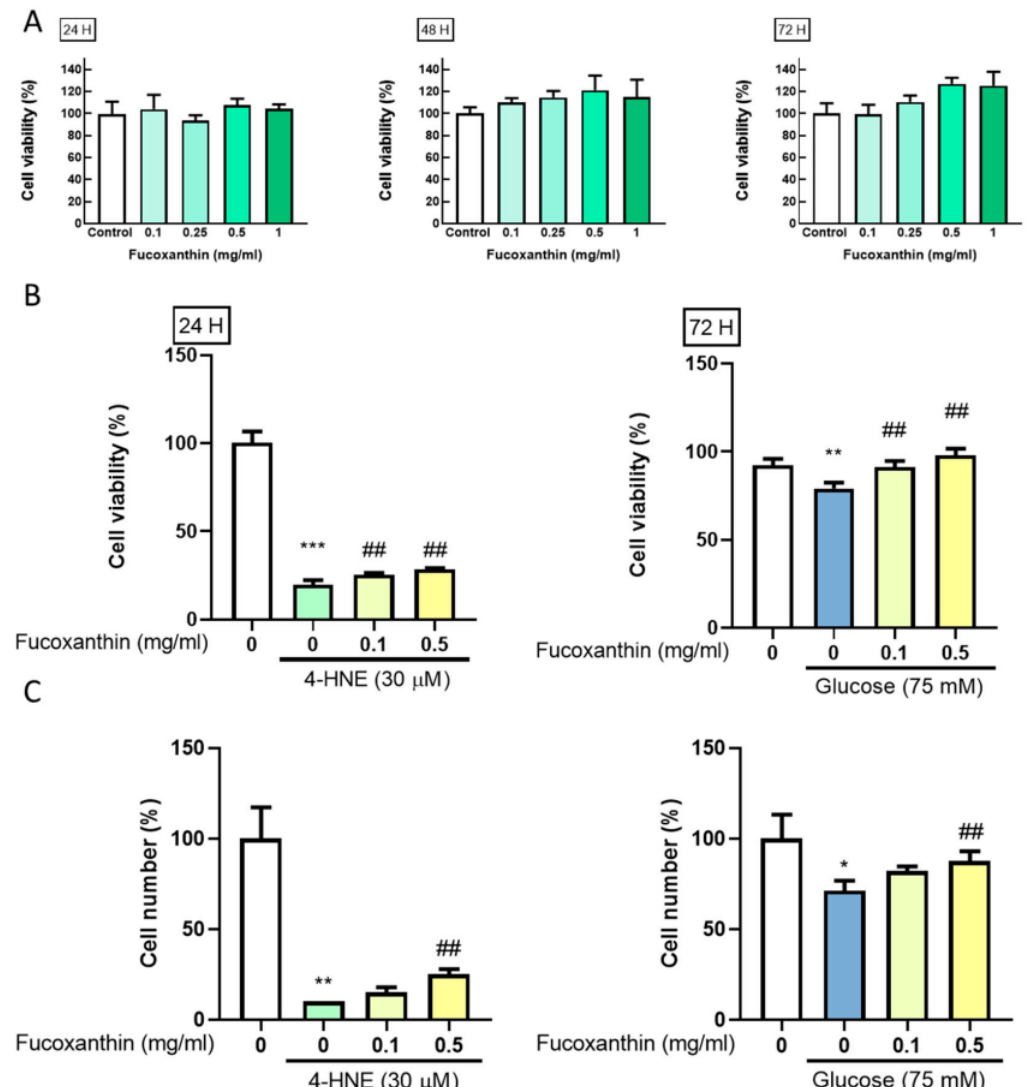
Figure 1. The e ff ects of high glucose, fucoxanthin, and the combination on ARPE19 cell viability. ARPE19 cells were cultured in a 96-well plate (3000 cell / well) after starvation with serum free Dulbecco’s Modified Eagle’s Medium (DMEM) F12 for 18 h. The cells were treated with di ff erent concentrations of ( A ) fucoxanthin for 24, 48, or 72 h; combined with fucoxanthin induced by 30 µ M 4-hydroxynonenal (4-HNE) for 24 h or 75 mM glucose for 72 H ( n = 4). Used ( B ) MTT assay and ( C ) cell counting for analysis of the proliferation change. *, p < 0.05; **, p < 0.01; and ***, p < 0.001 compared with the non-treated group. ##, p < 0.01 compared with the induced group (glucose 75 mM / 4-HNE 30 µ